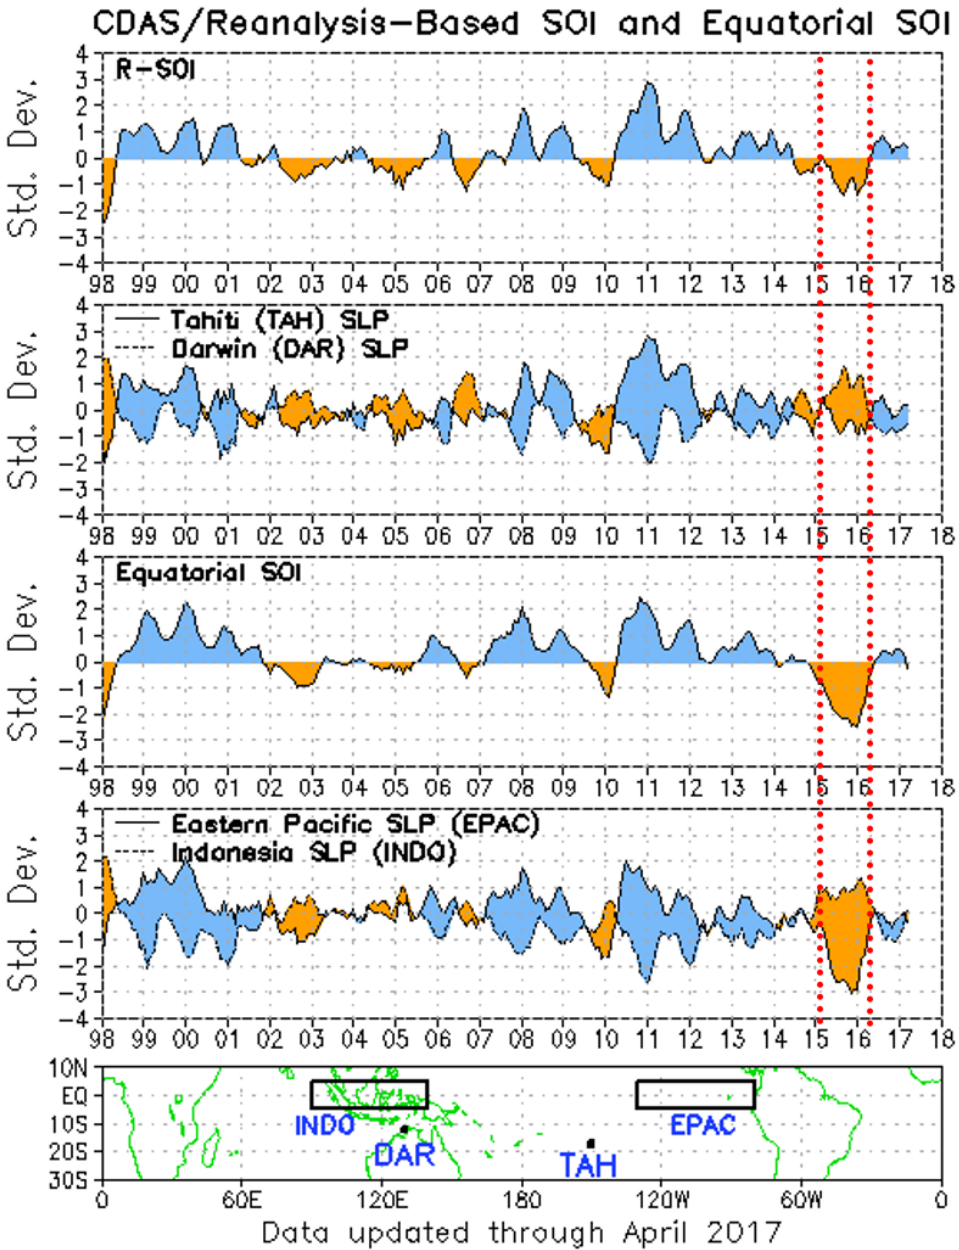
Figure 6. Variation in the Southern Oscillation Index (SOI) during the 2015–2016 ENSO. The 2015–2016 ENSO period is bracketed by the red dotted lines. SOI is a measurement of the intensity of the ENSO. Plots courtesy of the U.S. National Weather Service Climate Prediction Center.